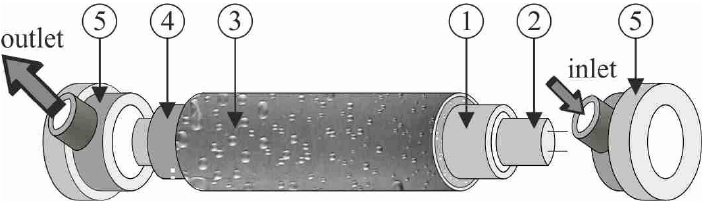
Figure 2. The schematic diagram of the test section: 1—an annular minigap, 2—a cartridge heater, 3—a glass pipe, 4—a copper pipe, and 5—a test section header.